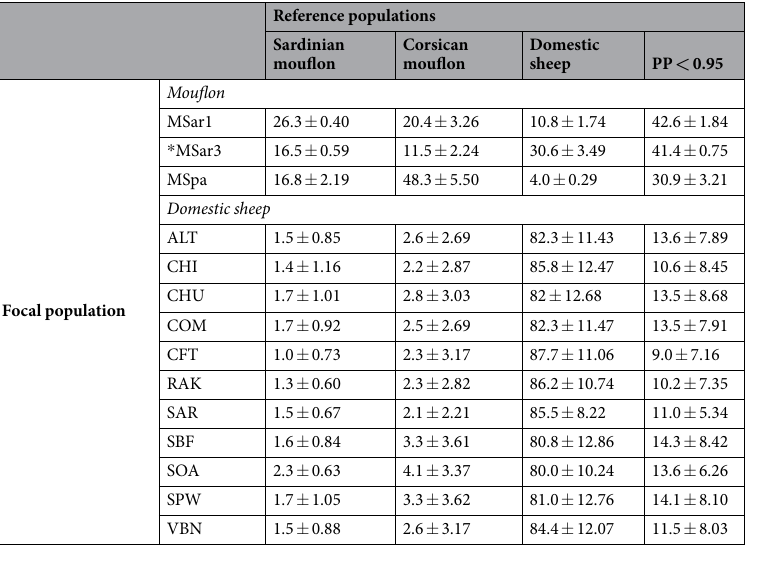
Table 2. Genome-wide local ancestry assignment values from PCAdmix. Shown is the average proportion of genome assigned by PCAdmix with posterior probability ≥ 0.95 to Sardinian mouflon, Corsican mouflon and domestic sheep, respectively. PP < 0.95 denotes the cumulative genome proportion remaining unassigned with posterior probability < 0.95. Averages were calculated across four reference sets (detailed in S5 Table), each comprising the same mouflon references (MSar2 and MHun for Sardinian and Corsican mouflon, respectively) and four different domestic sheep breeds (CAS, ASM, LAC and SAB_p). An asterisk highlights the mouflon population (MSar3) that presents a higher sheep genetic component than mouflon. For population abbreviations see Table